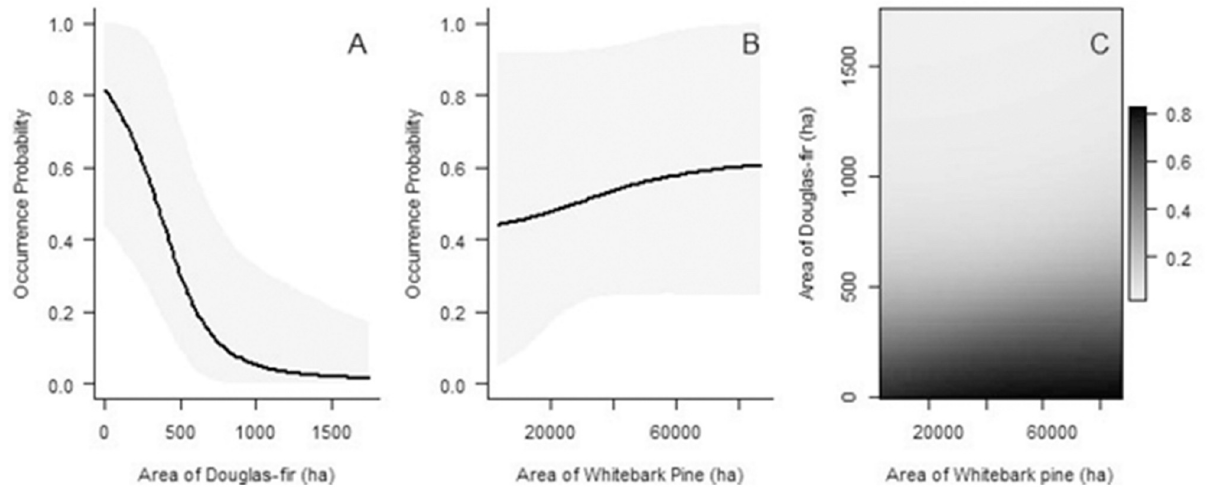
Fig 3. Predicted probability of Clark’s nutcracker occurrence during the breeding season as a function of area of (A) Douglas-fir, (B) whitebark pine, and (C) both species on the landscape. The graphs depict predictions based on data from infinite radius surveys. Values represent area of whitebark pine habitat within 32.6 km and Douglas-fir habitat within 3.2 km. On each graph, all variables in the models that are not shown on the graphs, are held at the mean. Gray shaded areas denote 95% Bayesian Credible Intervals.